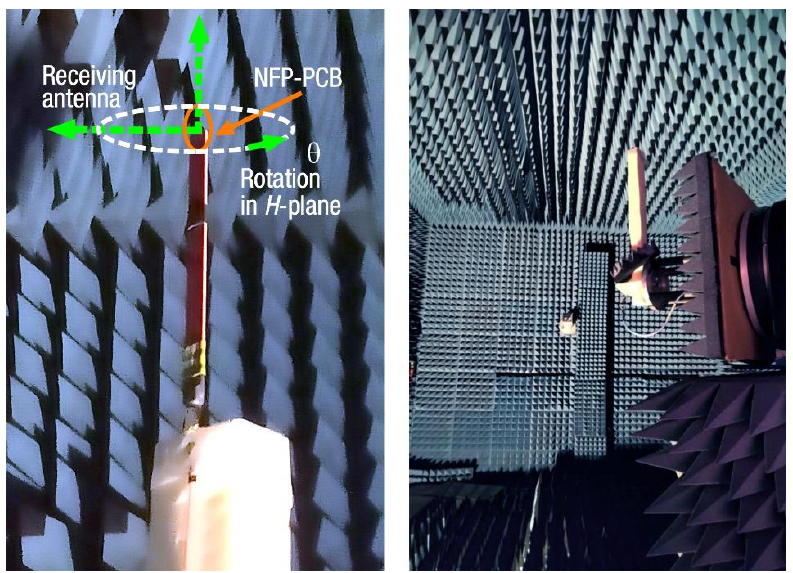
Figure 17. NFP-PCB vertically mounted to measure H -plane radiation pattern. Measuring setup in anechoic chamber.